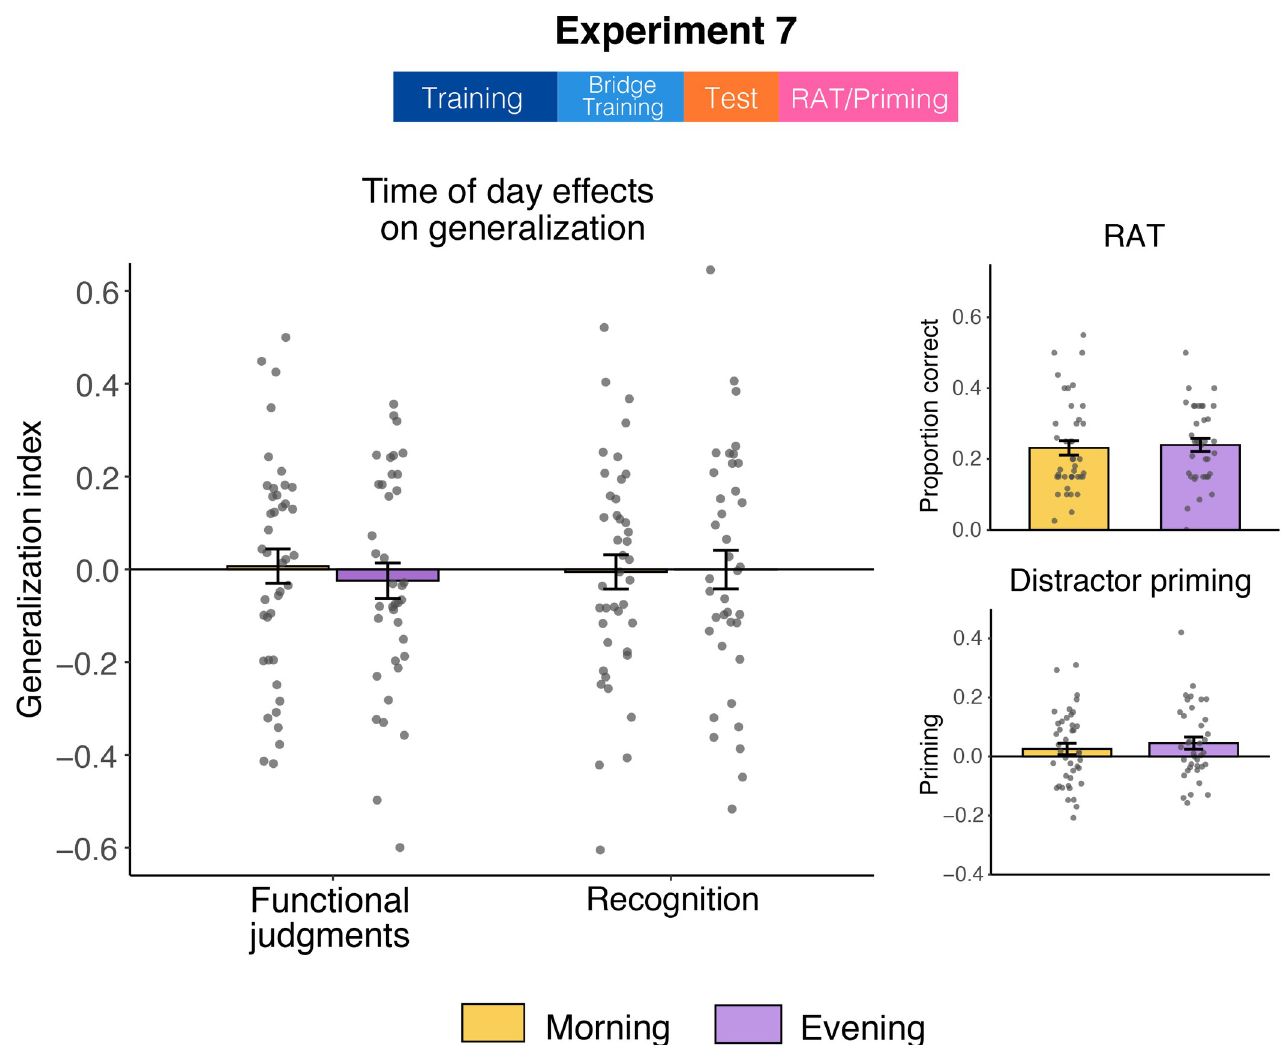
Fig 5. Time of day effects in Experiment 7. The generalization paradigm in this experiment was the same as Session 1 of Experiment 1 and Experiment 3. Additional measures, RAT and distractor priming, were administered after the generalization task, with performance shown on the right.